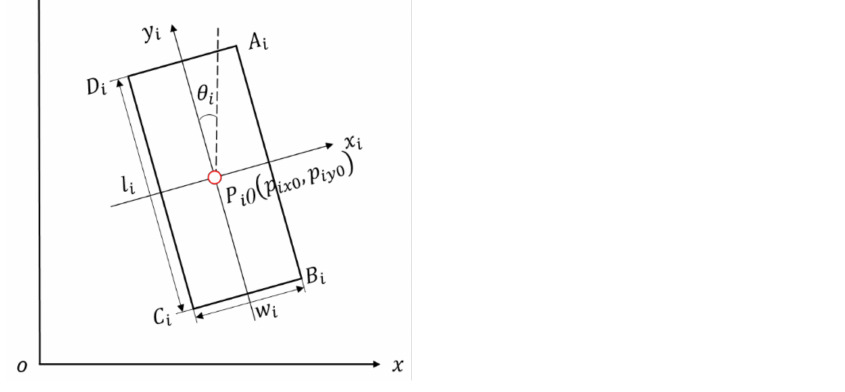
Figure 4. Visual representation of the vehicle pose estimation coordinate system. Vector p i can simplify the number of parameters in solving the obstacle pose. It can also express the four corners of the bounding box of the obstacle vehicle in the two- dimensional plane. A description of the bounding box corners A i , B i , C i , and D i is shown in Equation (2).